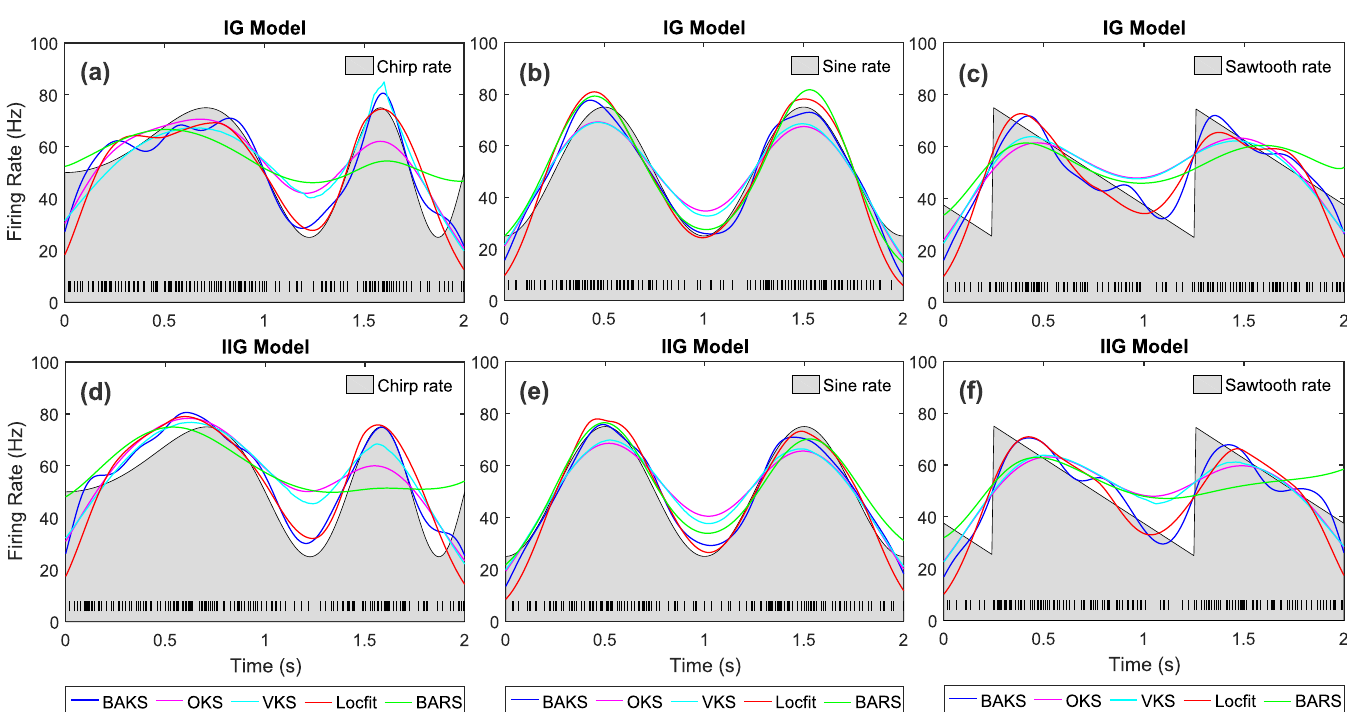
Fig 5. Comparison of firing rate estimates across all methods. (a)-(c) Firing rate estimates from IG model with chirp, sine, and sawtooth rate functions, respectively. (d)-(f) Firing rate estimates from IIG model with chirp, sine, and sawtooth rate functions, respectively. Black lines with gray-shaded regions indicate the underlying rate functions. Black raster in the bottom of each plot represents the spike train generated from the associated model and underlying rate function.